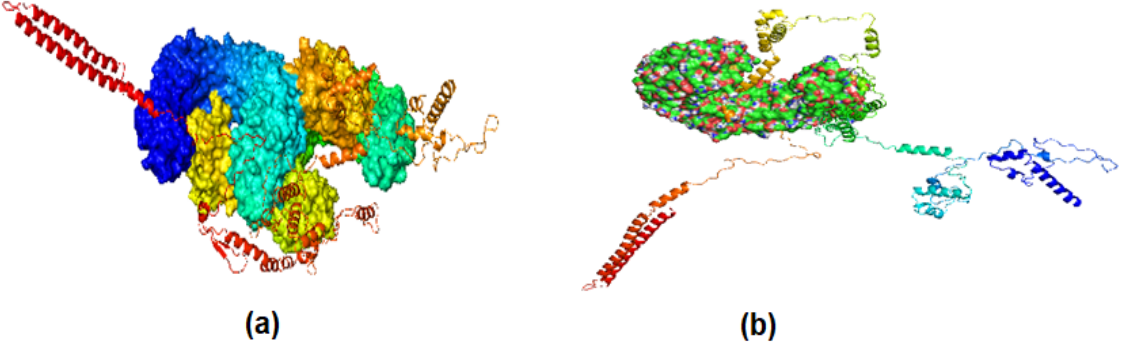
Figure 4. Molecular docking; ( a ) docking of vaccine constructs with TLR3; ( b ) docking vaccine construct of TLR4. The varying colors represents different chains of the interacting molecules.